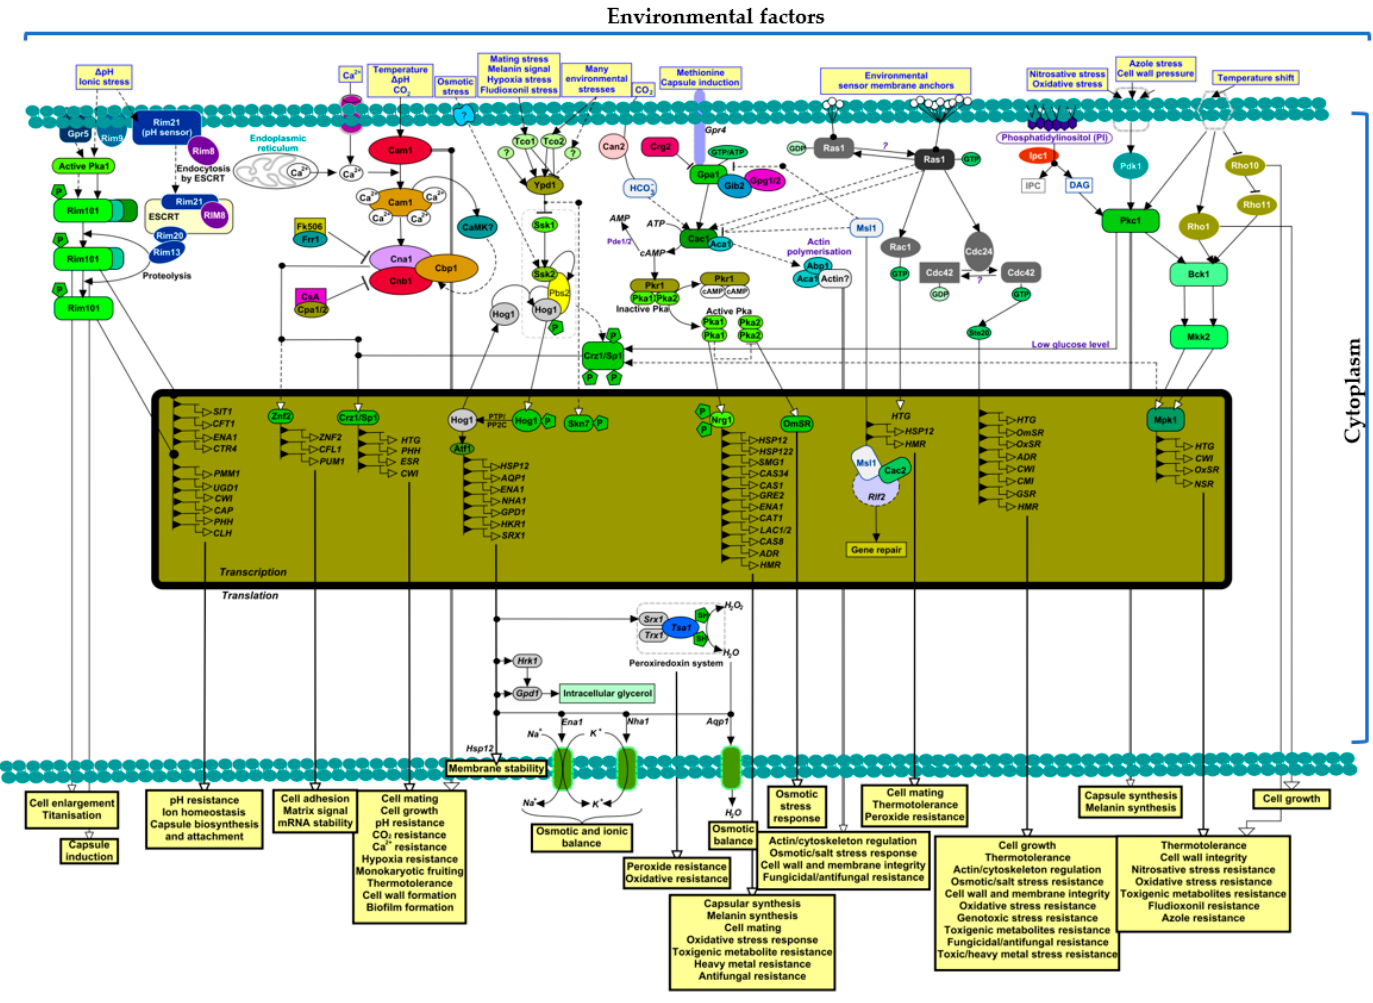
Figure 1. The interplay of different signalling pathways that enable C. neoformans to turn environmental stresses into phenotypic and physiologic advantages that help in the production of virulence factors during pathogenesis in the host. A number of pathways are indicated above. The Grp5–Rim101 is a Pka-dependent transcriptional